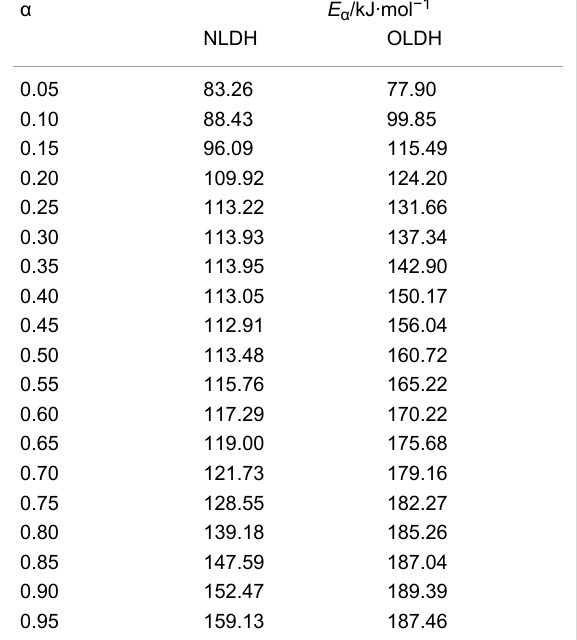
Table 4: Apparent activation energies E α of LDH degradation in N 2